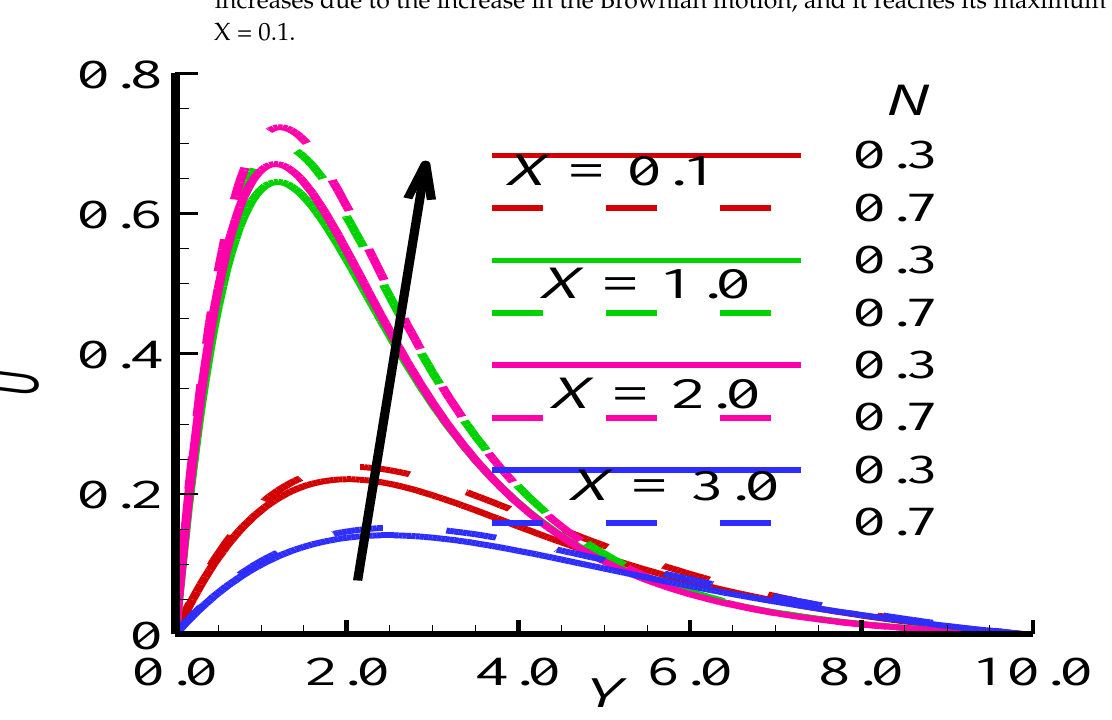
Figure 2. Outcomes of radiation parameter N on velocity distribution U when Nb = 1.5, Nt = 1.5, Pr = 7.0, and Sc = 10.0.